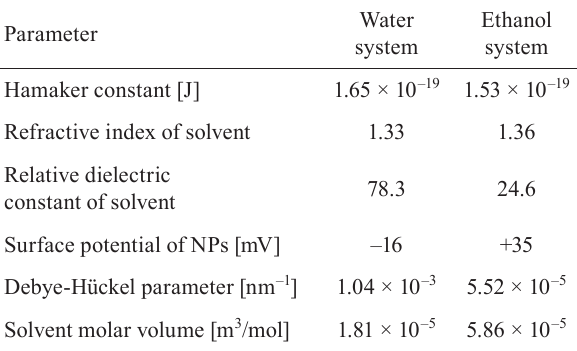
Table 1 Parameter values used for the calculation of particle interaction between two spherical 1-thioglycerol-capped ZnS NPs in water or ethanol